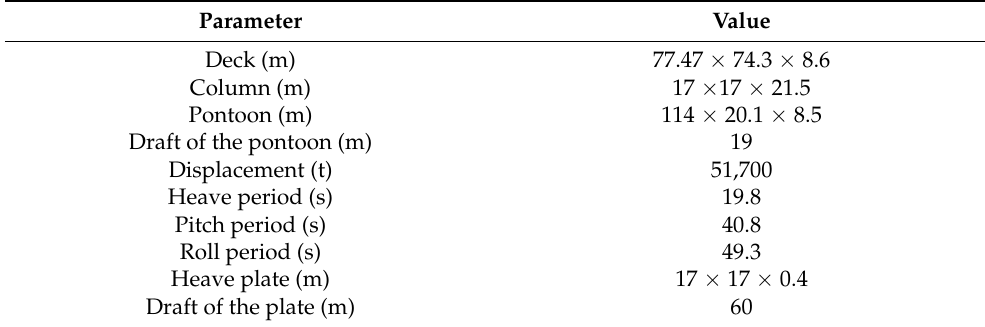
Table 1. The physical parameters of the platform and